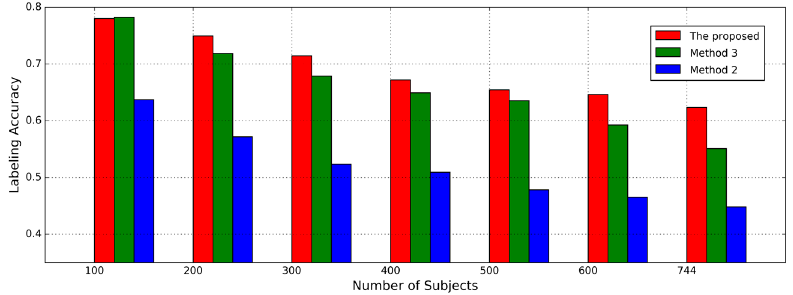
Figure 7. The impact of the number of subjects on gait labeling accuracy. The complete length of inertial sensor data time series in probe dataset is used to determine the labels.